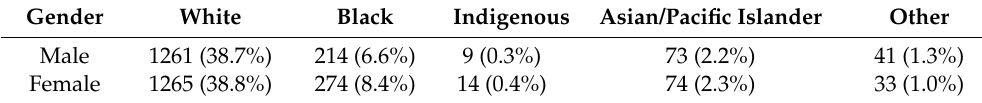
Table 1. Gender and race demographics of WJ IV ages 9–19 norm sample used in the current